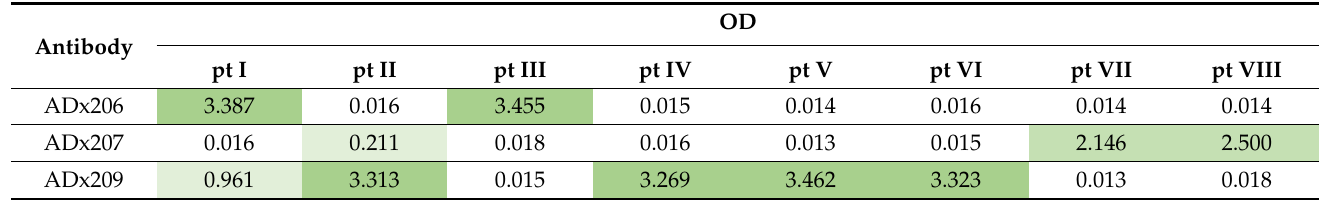
Table 1. OD450 nm–650 nm values obtained from the indirect ELISA for epitope mapping. Figure 2. Epitope recognition sites of ADx206, ADx209, and ADx207 antibodies in the Coil 2/B re- gion of Nf-L protein. The two short and one long peptide immunization sites (Section 4.1) are de-